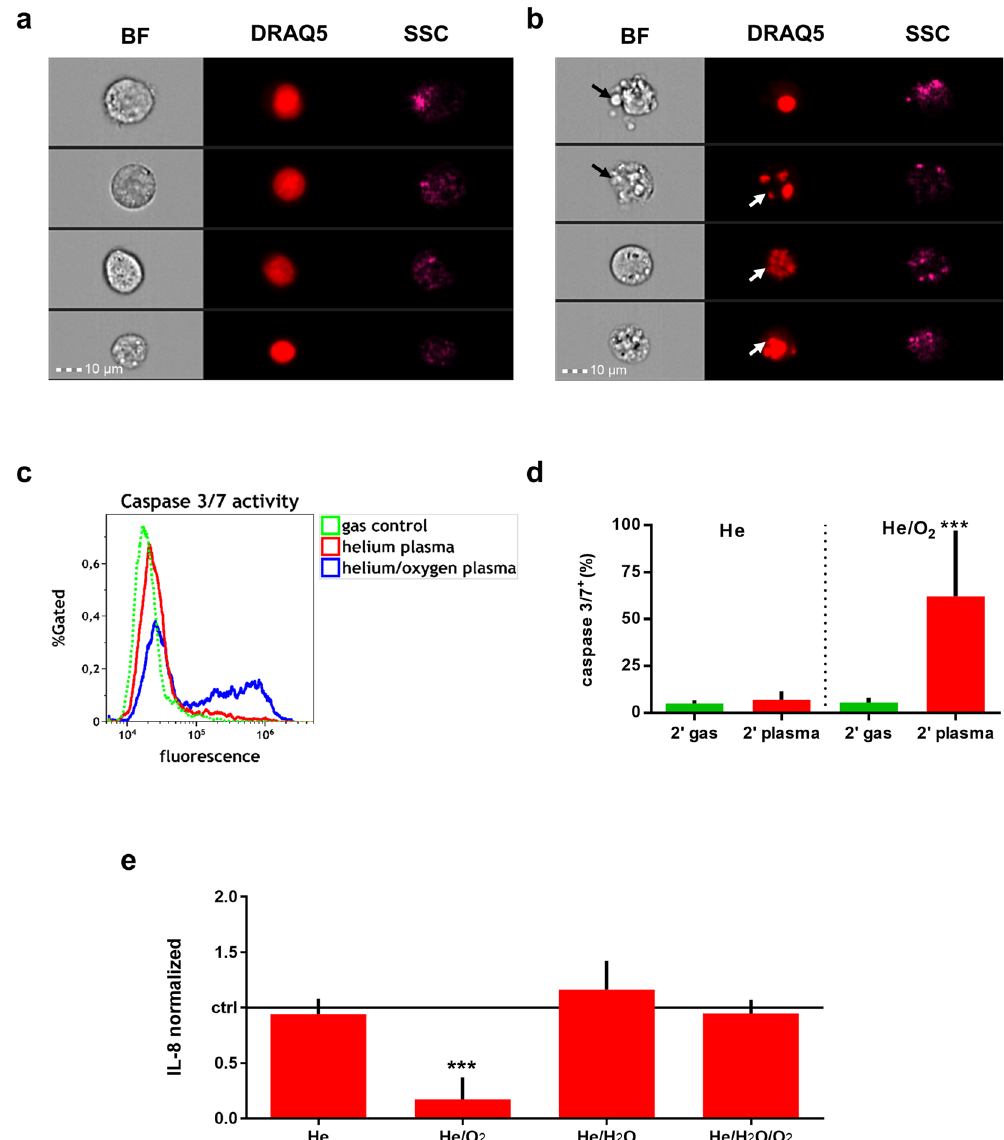
Figure 3. The mode of cytotoxicity of He/O 2 plasma in THP-1 cells was apoptosis. ( a ) Control THP-1 cells showed a round morphology (BF, bright field, left array) with intact nuclei (DRAQ5, middle panel) and characteristic side scatter patterns (SSC, right panel) as measured using image cytometry. ( b ) Plasma-treated THP-1 cells displayed altered morphological features with membrane blebbing and vacuolization (BF) and segmented nuclei (DRAQ5). ( c ) Representative histograms of activated caspases 3/7 in plasma-treated cells. ( d ) Quantification of percent of cells being positive for active caspases 3/7 with a significant increase in He/O 2 but not the He plasma condition. ( e ) THP-1 cell culture supernatant was investigated for IL-8 24 h after exposure to plasma generated using different feed gas compositions. Final concentrations where normalized to each gas- treated control, respectively. He/O 2 but not any other gas plasma significantly decreased IL-8 concentrations in the supernatant of THP-1 cells. Data are one representative ( a , b , c ) or mean ( d , e ) + S.D. of three experiments. Statistical analysis was determined using the t-test ( *** p <